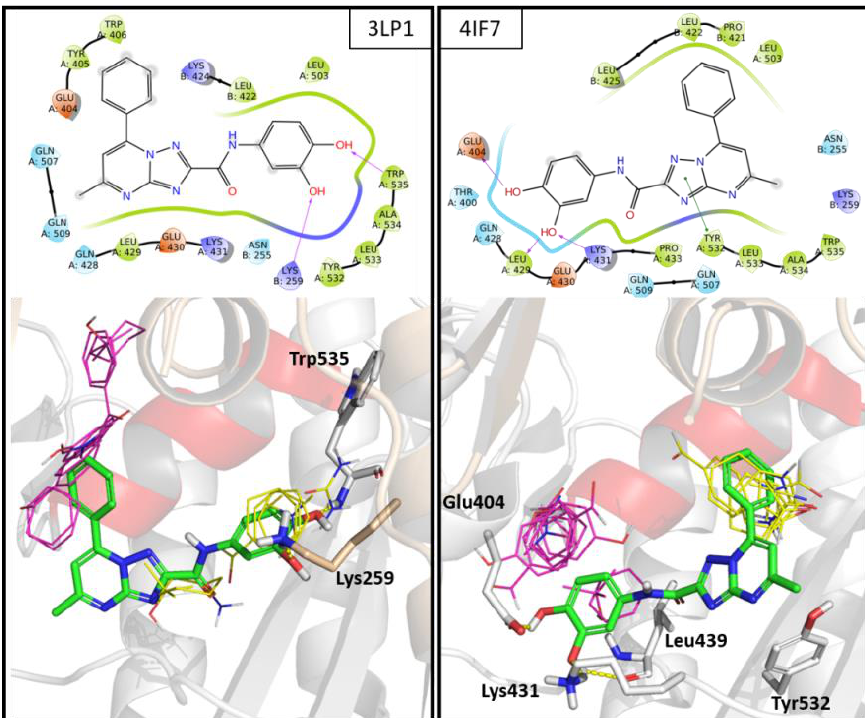
Figure 5. 2D and 3D representation of 18g binding mode produced by docking studies on 3LP1 and 4I7F structure. Magenta lines, Hs1 probes; yellow lines, Hs2 probes; red cartoon, α -helix 14.